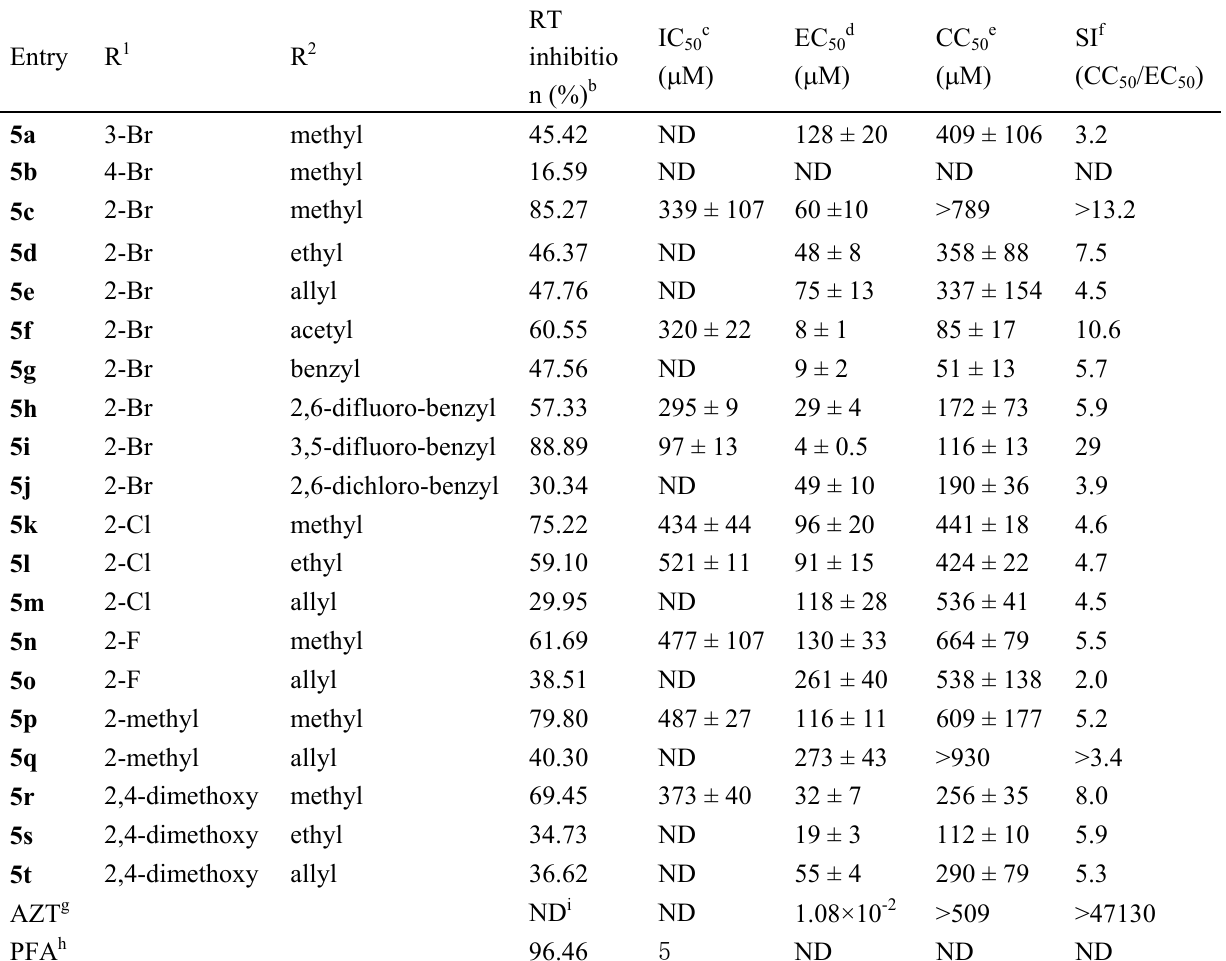
Table 1. Structures and anti-HIV-1 activities of ( E )- N- phenylstyryl -N- alkylacetamides 5 .